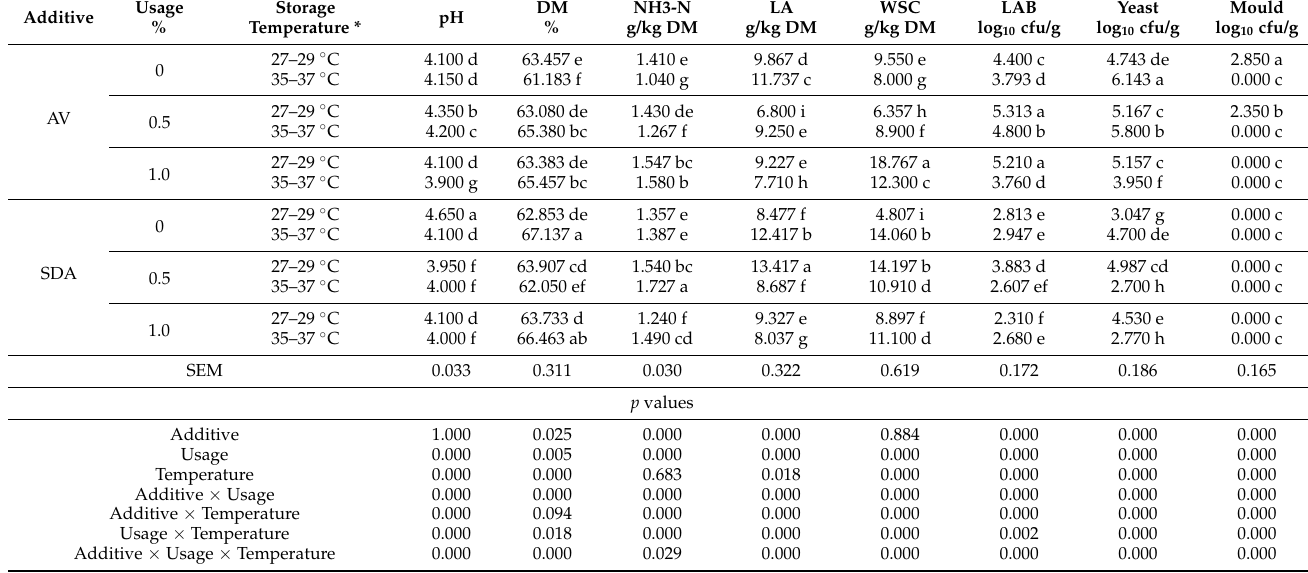
Table 3. Effects of additives and storage conditions on the fourth day of aerobic stability of high moisture maize